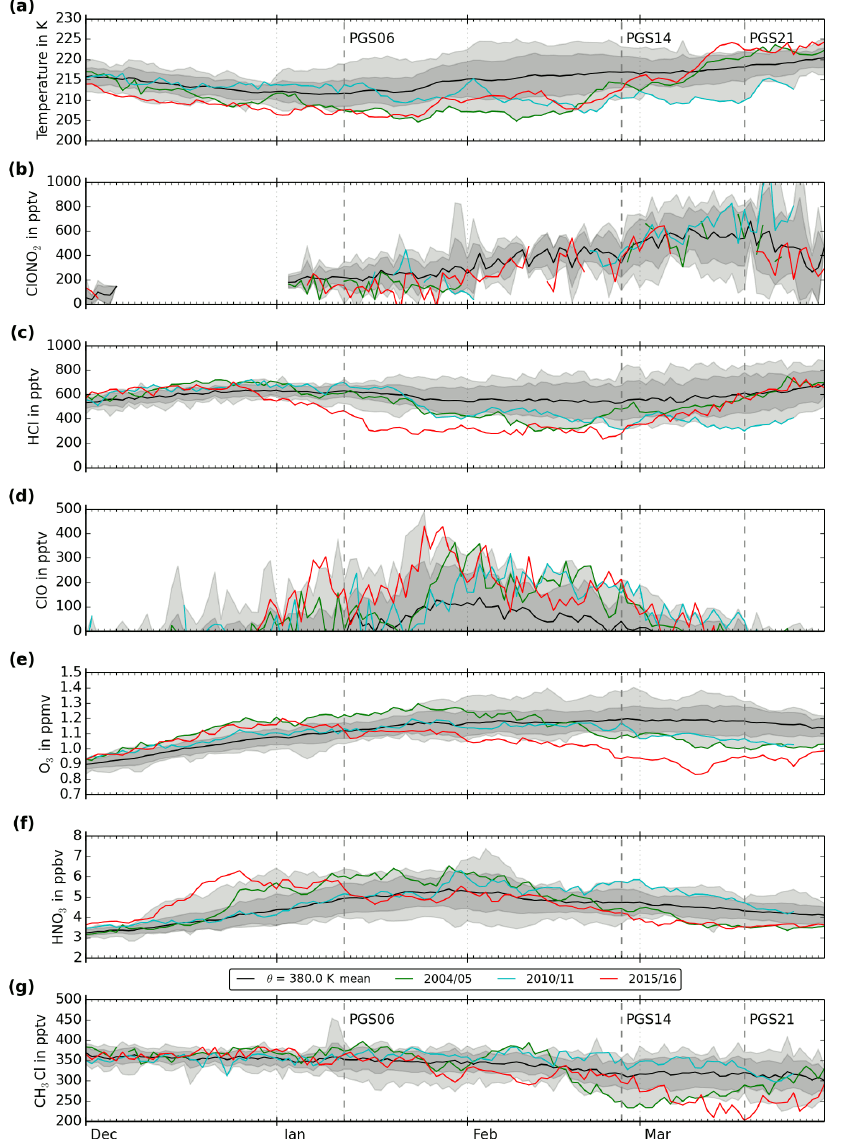
Figure 2. Vortex average time series of (a) temperature (MERRA-2) and volume mixing ratios of (b) ClONO 2 (ACE-FTS), (c) HCl, (d) day- time ClO, (e) O 3 , (f) HNO 3 , and (g) CH 3 Cl (Aura/MLS) for the period 2004–2018 over the Arctic at θ = 380K ( ≈ 15km in January). The black line marks the average value for each day, the dark shaded area marks the standard deviation of each day between different years, and the light shaded area marks minimum and maximum values within the time period. The Arctic winter 2015/16 has been excluded from all of these measures. Mean values for the Arctic winters 2004/05 (green), 2010/11 (cyan), and 2015/16 (red) are marked separately. Days with aircraft measurements discussed in this paper are marked with dashed